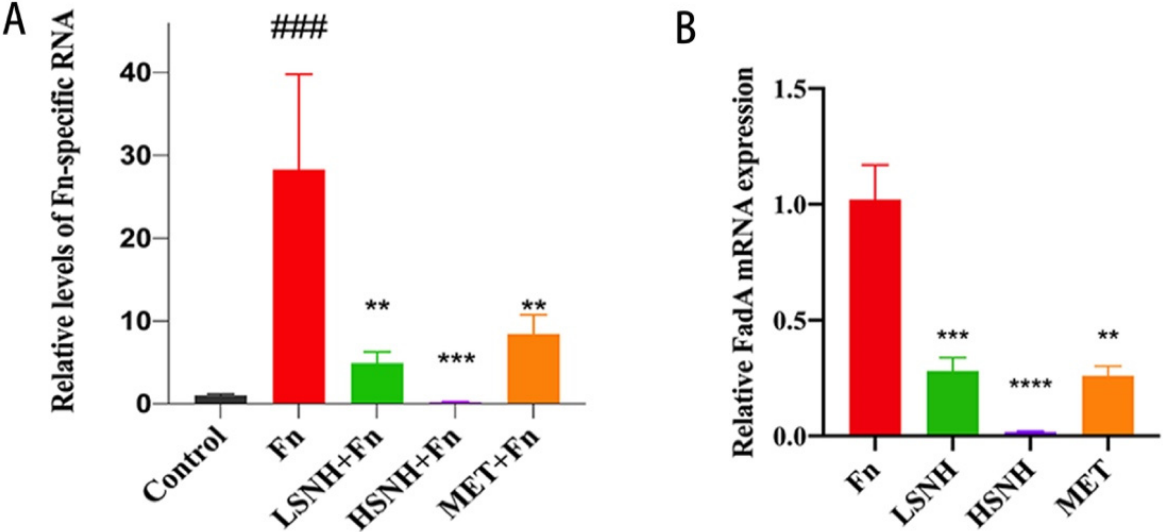
Figure 6. Effect of SNH on Fn in HCT116-xenograft tumors with intratumor colonization of Fn . ( A ) QPCR of Fn -specific RNA in the tumors of the mice engrafted with HCT116 cells with or without Fn colonization and SNH treatments. ( B ) QPCR of FadA RNA in the tumors of mice engrafted with HCT116 cells with Fn colonization and SNH treatment. All values were represented as mean ± SD, and p values < 0.05 were considered statistically significant. ** P < 0.01, *** p < 0.001, **** p < 0.0001, vs. Fn group. ### p < 0.001, vs. Control.